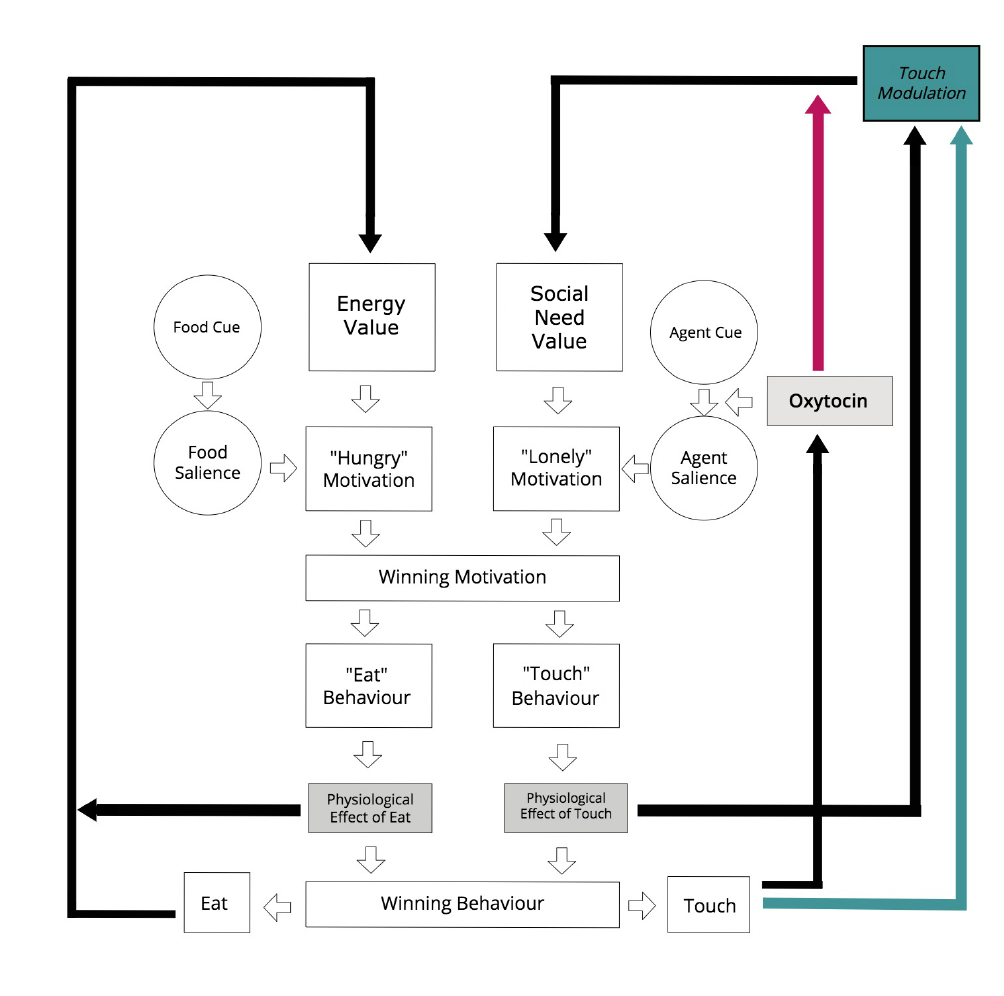
Figure 1. Visualisation of the internal ASA that each agent is equipped with. Calculations for both behavioural intensities are executed concurrently at each time step. Oxytocin exists outside of the main loop, modulating social salience and the satisfaction of the Social Need